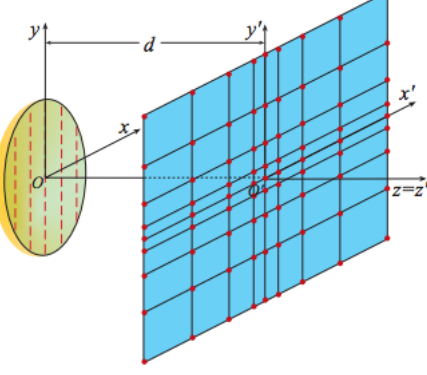
Figure 1. PWMS for a quasi-planar AUT.